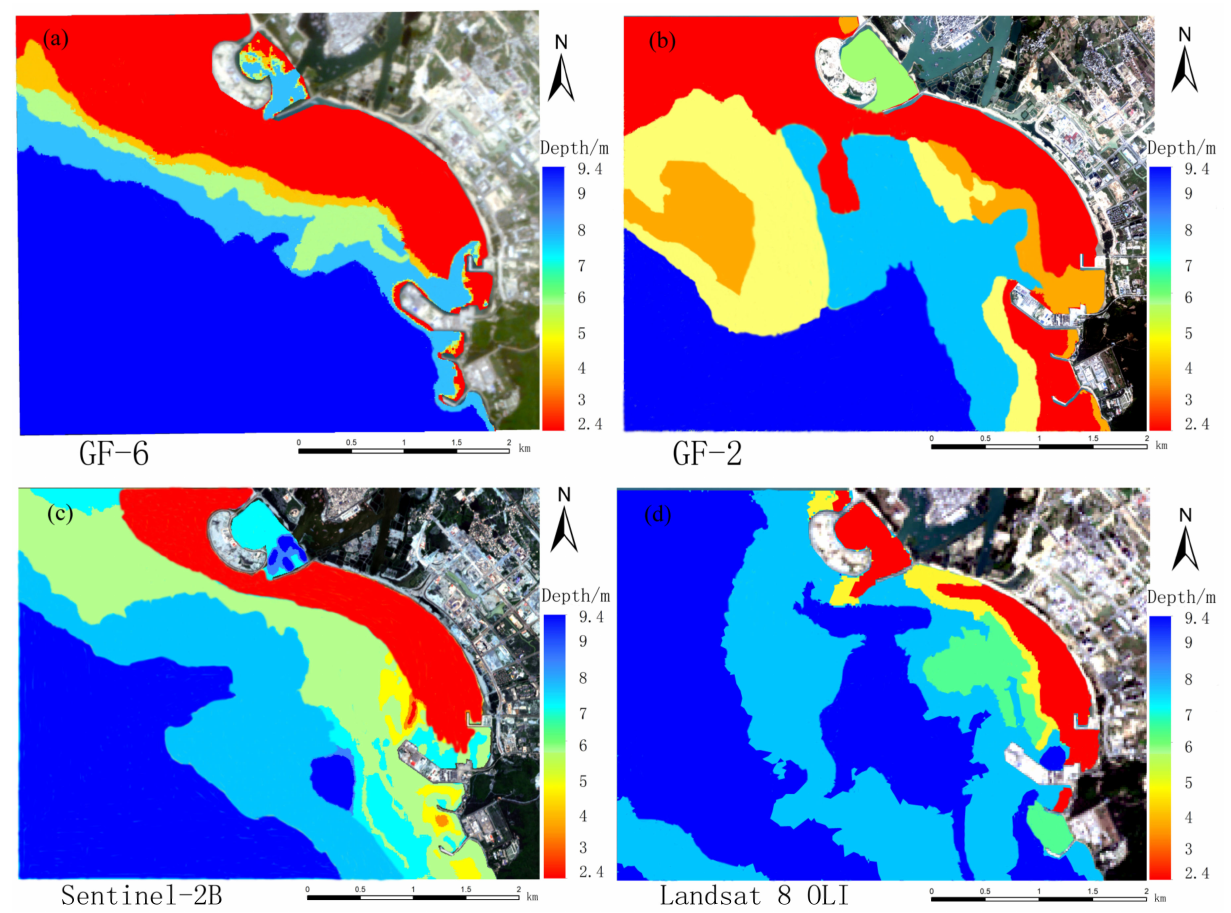
Figure 6. Inversion of water depth map by random forest model of a multispectral image: ( a ) GF-6; ( b ) GF-2; ( c ) Sentinel-2B; ( d ) Landsat 8